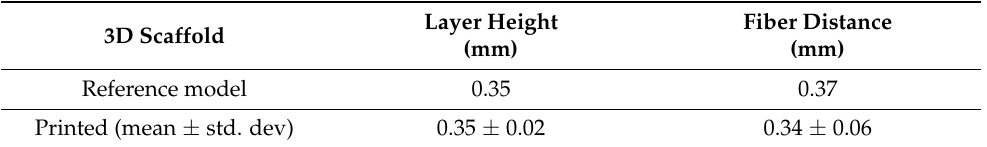
Table 2. Scaffold 3D printing and subsequent loading of MSC secretome by adsorption. Comparison between dimensions of the 3D model and 3D-printed PCL scaffolds (measure from SEM images, n = 6). 3D